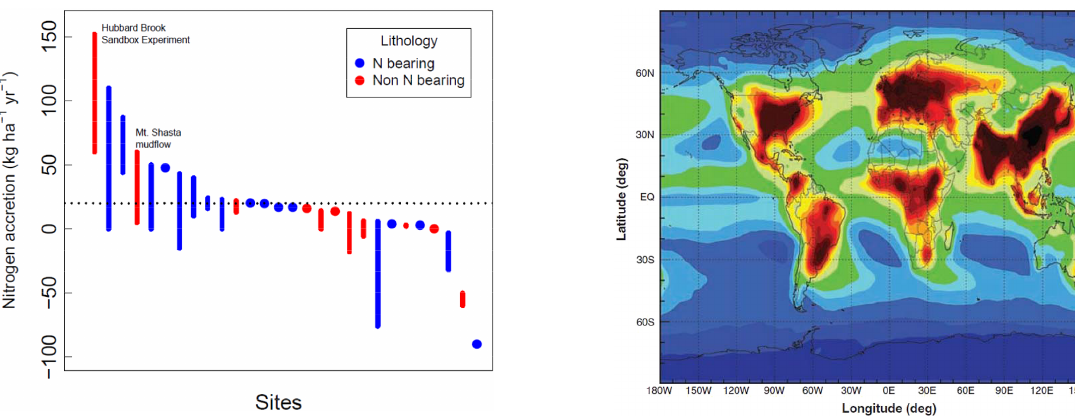
Figure 6. Rates of inorganic N deposition rates based on total N emissions in units ofkgNha − 1 yr − 1 (from Galloway et al.,